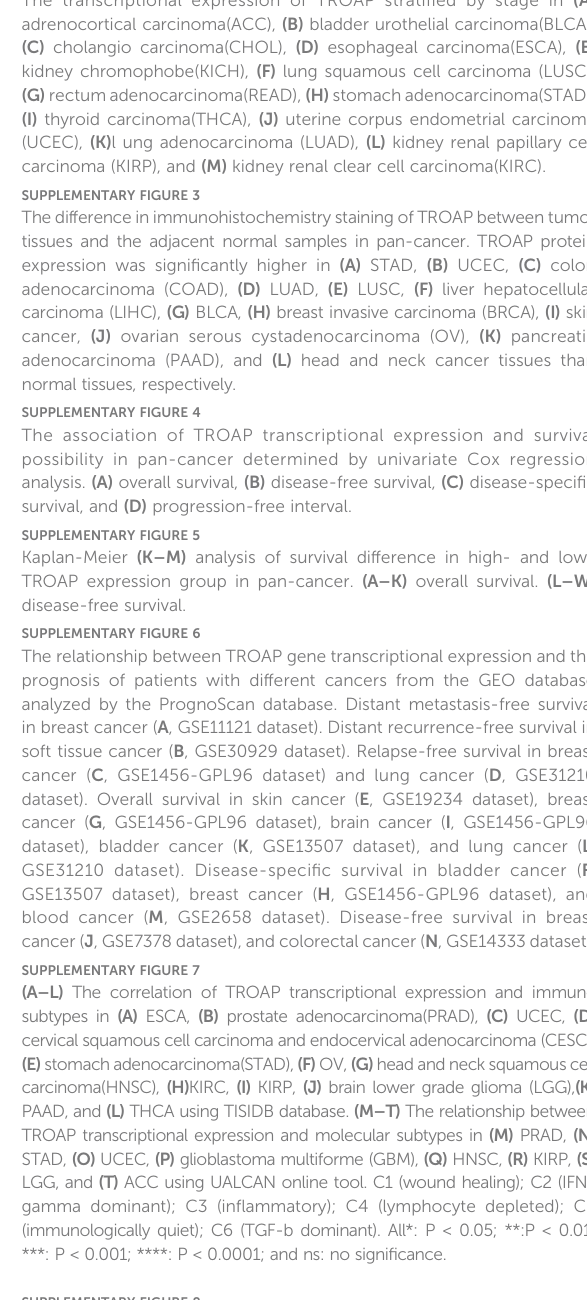
SUPPLEMENTARY FIGURE 8 The correlation of the TROAP expression with the in fi ltration of six immune cell types, namely B cell, CD4+ T cell, CD8+ T cell, neutrophil, macrophage, and dendritic cell. SUPPLEMENTARY FIGURE 9 The relationship between the transcriptional expression of TROAP and drug sensitivity in CTRP (A) and GDSC (B) databases, respectively. GDSC, Genomics of Drug Sensitivity in Cancer; CTRP, The Cancer Therapeutics Response Portal. SUPPLEMENTARY FIGURE 10 Tumor immune single-cell analysis was performed on TROAP in the 26 cancers using the TISCH